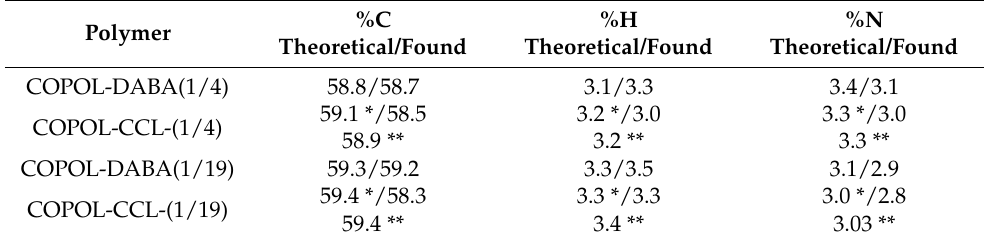
Table 2. Elemental analysis of copolyimides and their crosslinked counterparts.